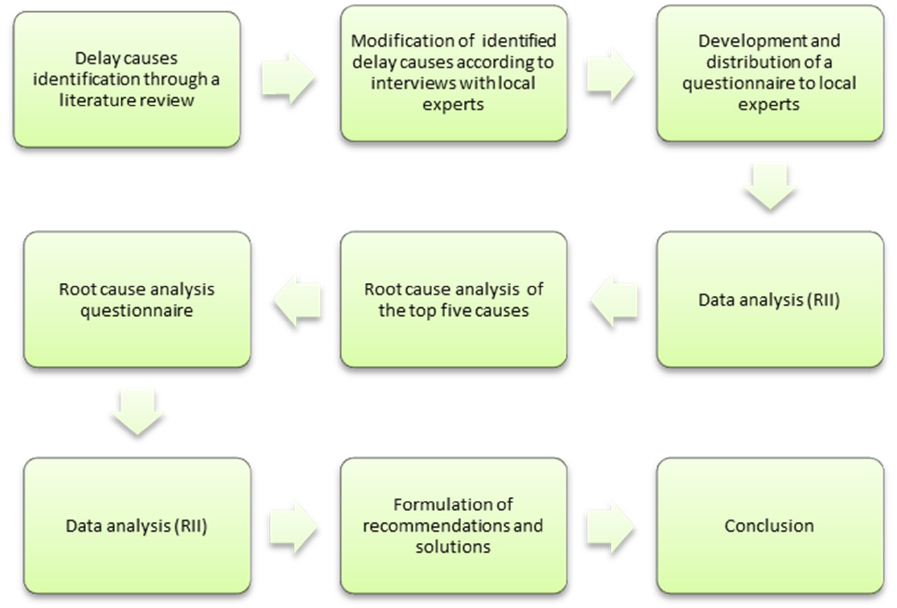
Figure 1. Methodology. Figure 1.